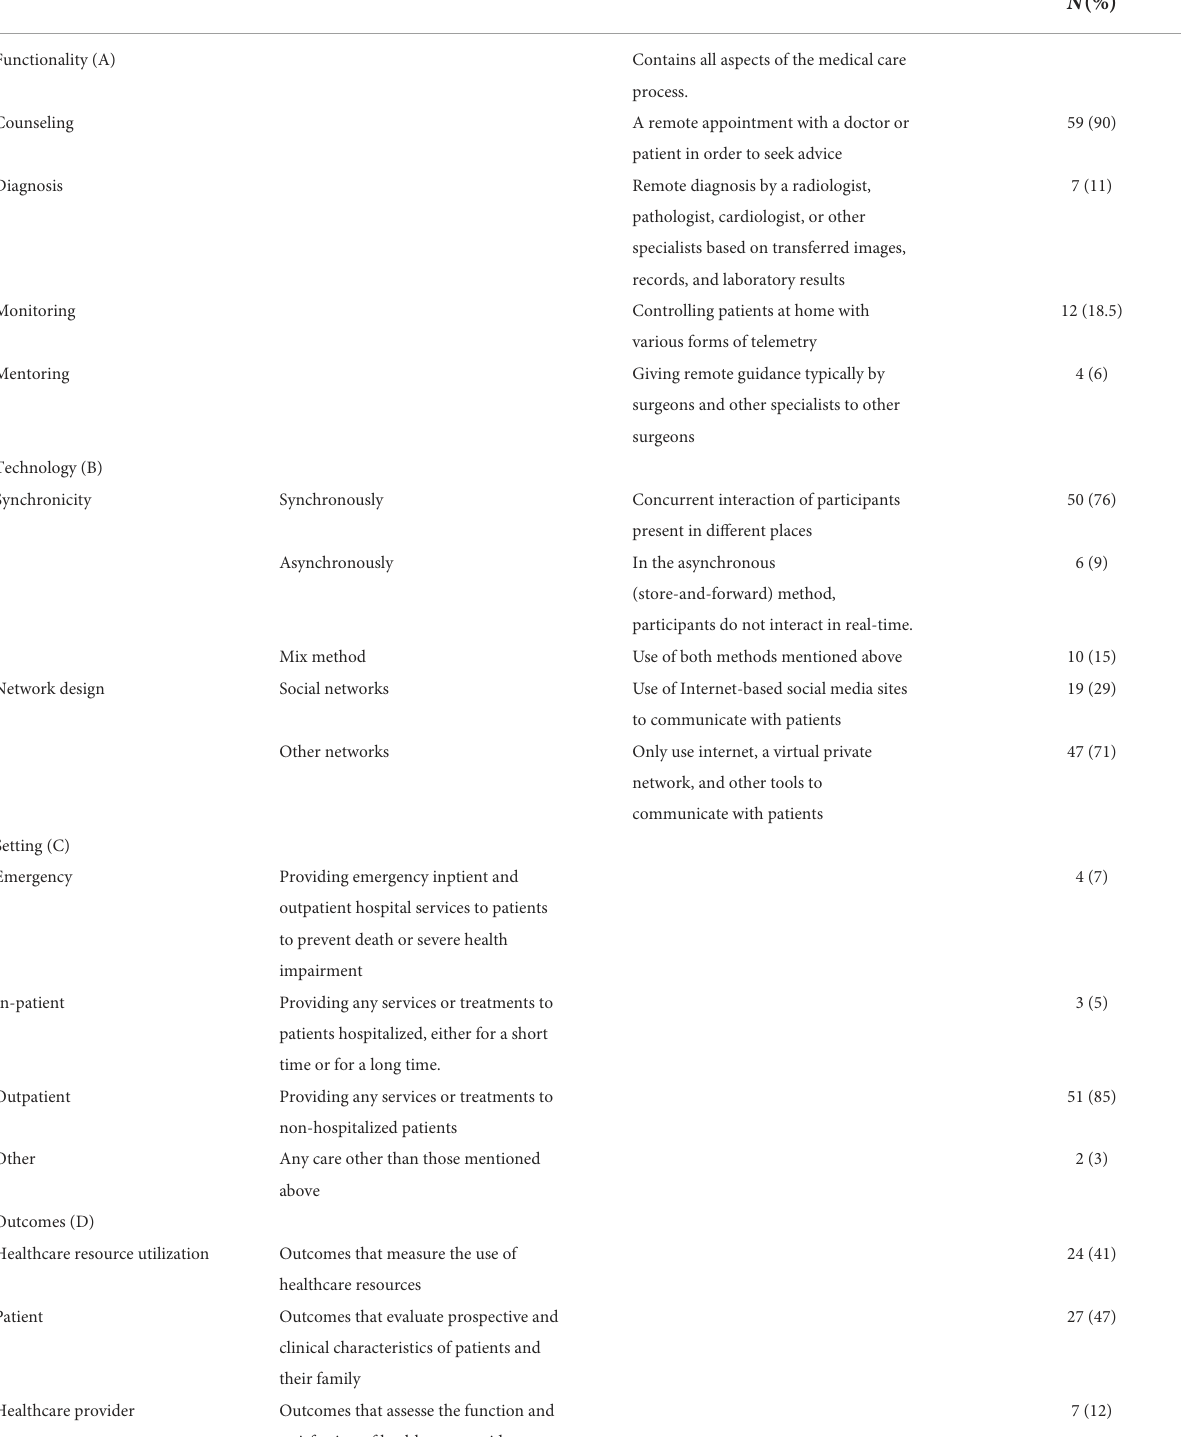
TABLE 2 Results based on data